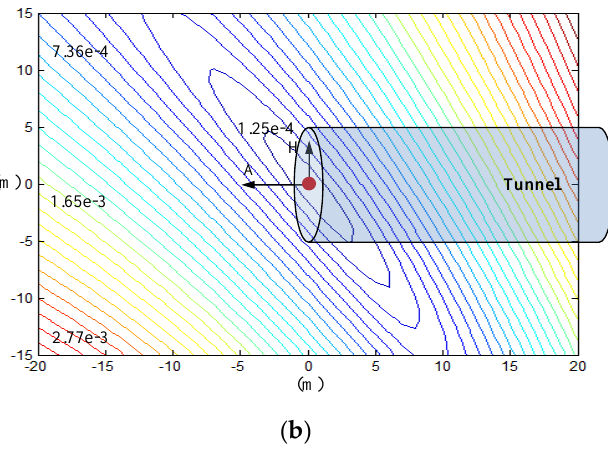
Figure 7. Twin-tube array and residual space: ( a ) twin-tube tunnel array; ( b ) residual space in the A-H plane, and the maximum value of the residual variation rate is 2.77 × 10 − 3 , and the residual space no longer exists in the axial direction.